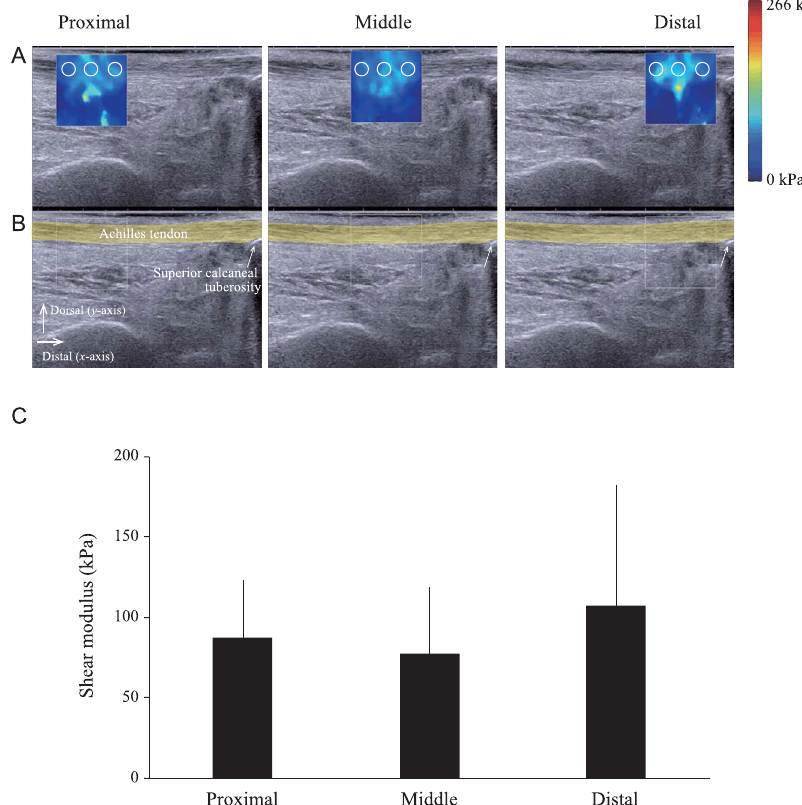
Figure 4. Ultrasound elastography demonstrating homogeneous shear modulus along the Achilles tendon. ( A , B ) Representative sagittal longitudinal ultrasound elastogram (Row A ) and B-mode image (Row B ) of the lower leg. The 15 × 15 mm region of interest (colored map at the top and white square line at the bottom) is positioned at the proximal, middle, and distal regions along the line of the Achilles tendon. For the sake of clarity of the Achilles tendon geometry, the echographic image without the color map, with the Achilles tendon in yellow, is depicted in the Row ( B ). The colored regions in the first row represent the shear elasticity map (stiffer areas are coded in red and softer areas in blue) with the color scale to the right of the figure. The mean values obtained in these three circular regions (2-mm diameter) are then averaged. In Row ( B ), the Achilles tendon is highlighted with a thick yellow line. The superior calcaneal tuberosity is indicated by a white arrow. ( C ) Shear modulus is compared between three different proximo-distal locations. A one-way ANOVA was used to examine the differences among the three locations of the shear modulus and indicated no significant differences. Each line represents the mean and SD of n =